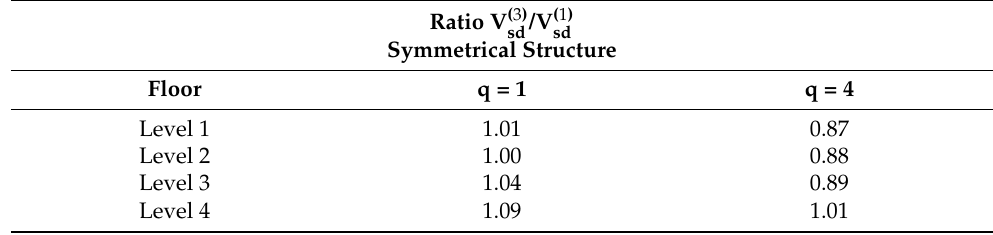
Table 21. Ratios between the shears from the linear dynamic analysis with corrected stiffness and the linear static analysis for all of the multi-storey building case studies with the symmetrical disposition of the X-CBFs.